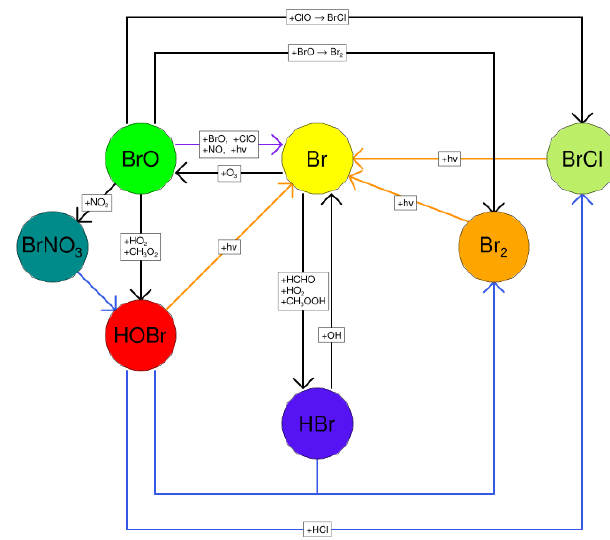
Figure 1. The major reactions of the bromine cycle. Orange lines in- dicate photolysis reactions, blue lines heterogeneous reactions, and black lines other gas-phase reactions. BrO → Br includes one pho- tolysis reaction and three other